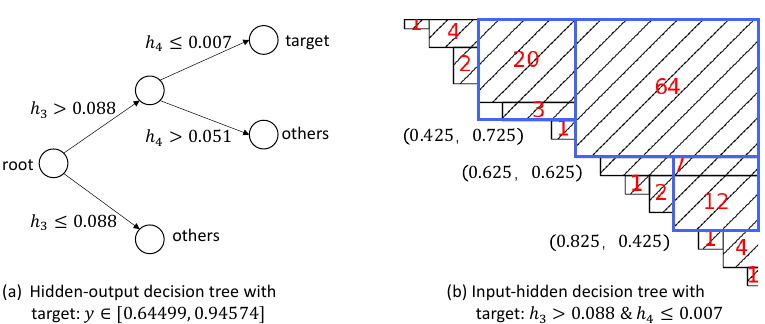
Figure 12. Decision trees for the target y ∈ [ 0.64499,0.94547 ] .